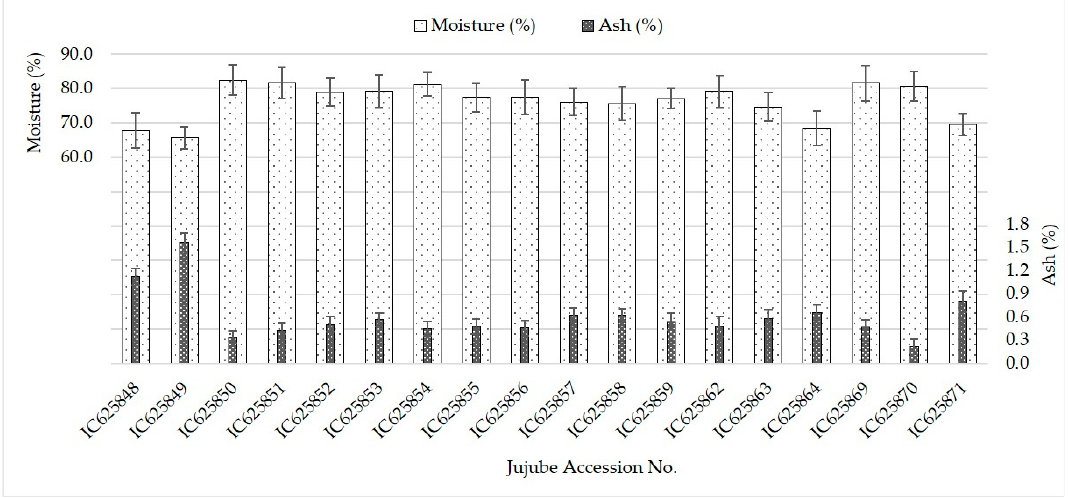
Figure 2. Mean values for the moisture content (%, Y axis, left) and ash content (%, Y axis, right) of jujube fruit ( n = 40) for each of the 18 genotypes of jujube tree studied in the two-year study. Mean values ± sd, n = 40.